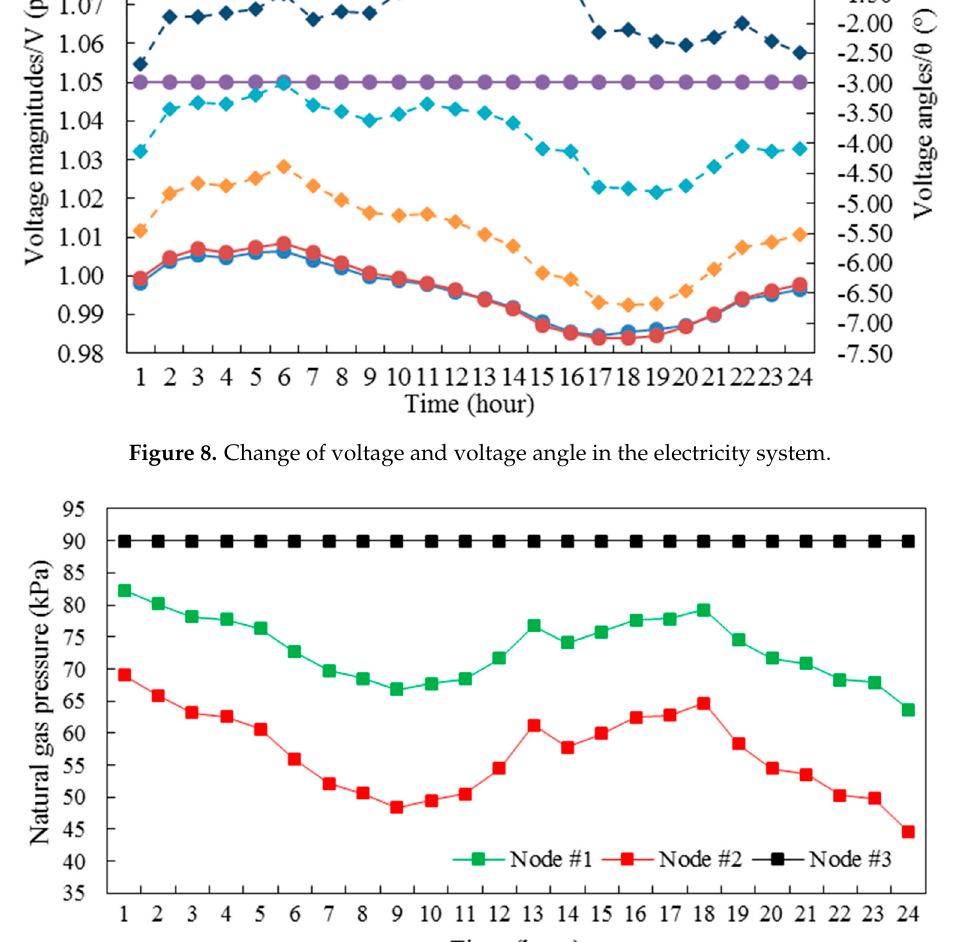
Figure 9. Change of node pressure in natural gas system.